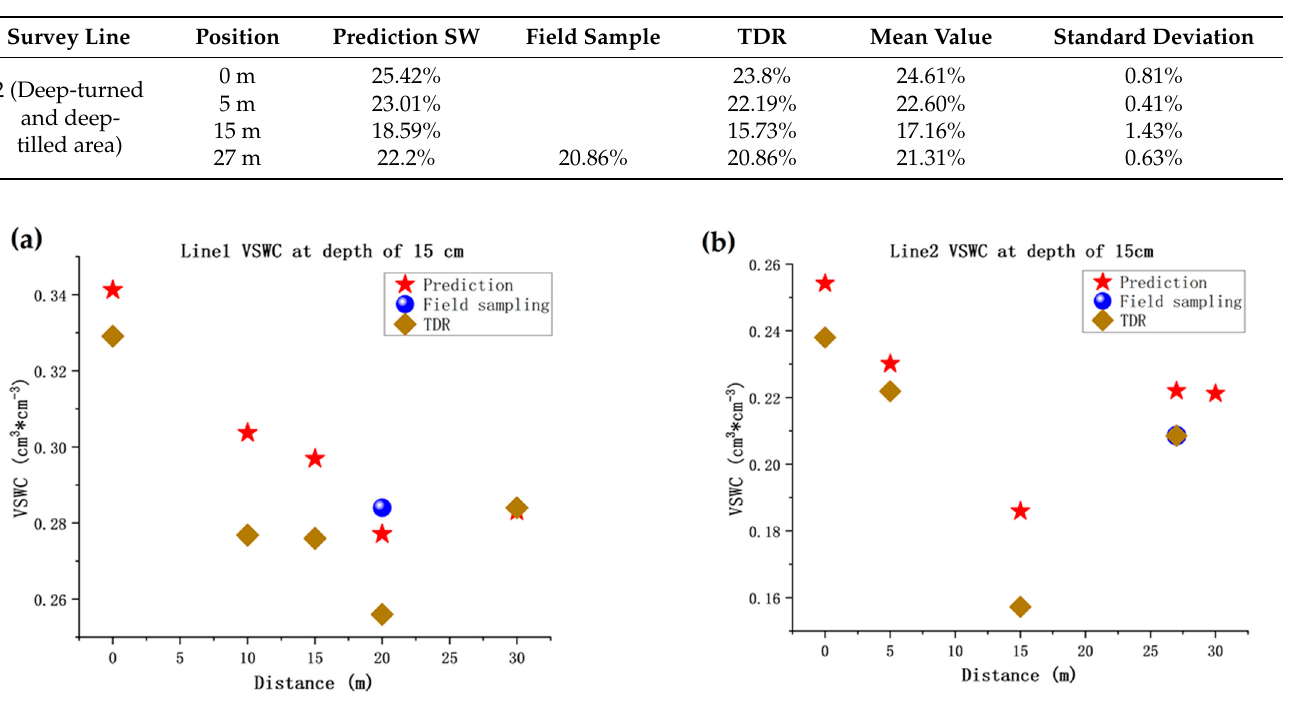
Figure 11. Comparison of predicted and measured values. ( a ) VSWC values obtained by different methods at 15 cm under line 1; ( b ) VSWC values obtained by different methods at 15 cm under line 2. The red pentagram represents the predicted value inverted from GPRSW; the blue orb represents the field soil sampling, and the brown diamond represents the TDR probe sampling.